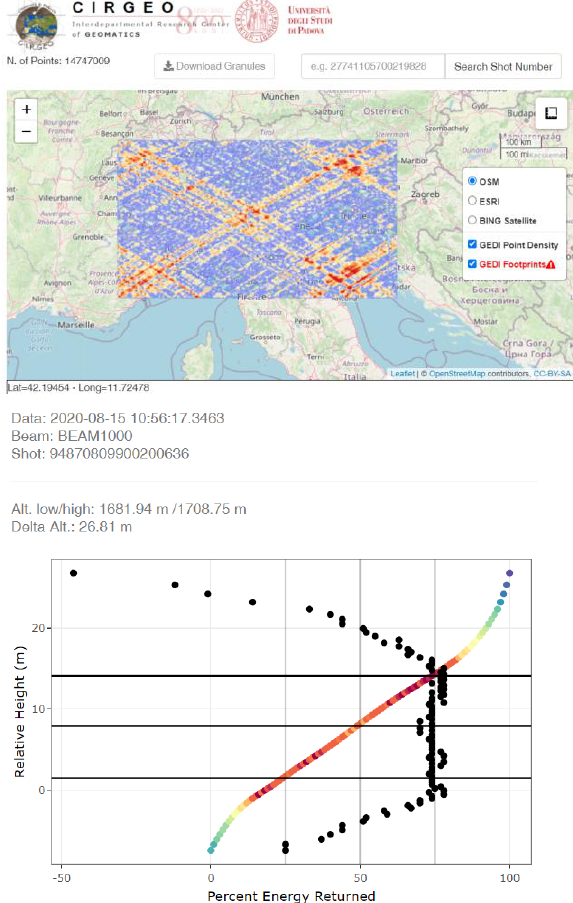
Figure 5. GEDI data interface – top is the area with available data, bottom is data from a single footprint. Colored points are the 100 RH metrics in GEDI data. Black points are first derivative of RH metrics.